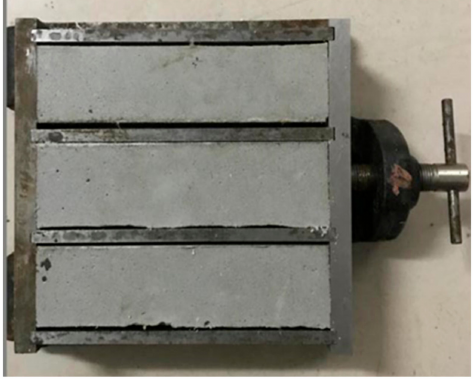
Figure 3. Cement mortar specimens.